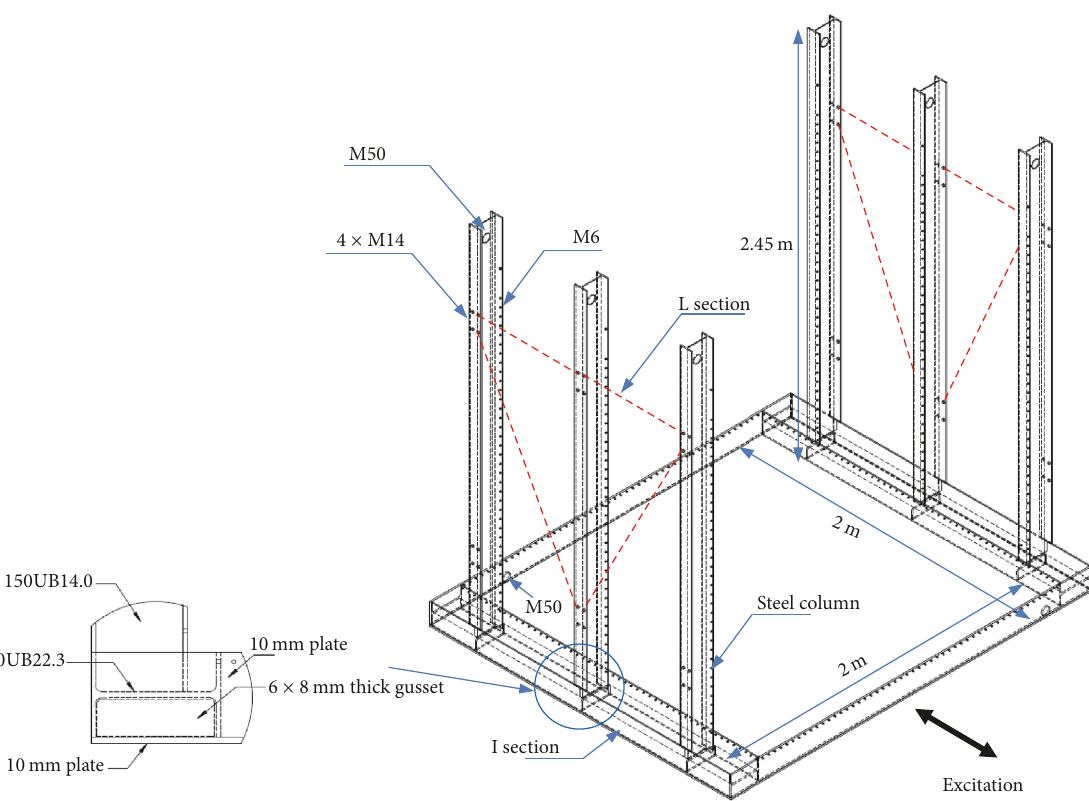
Figure 2: Details of the base and barrier